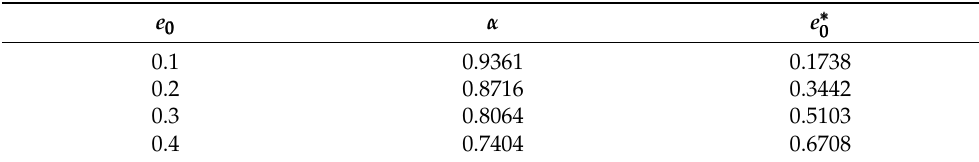
Table 1. Relationship of porosity